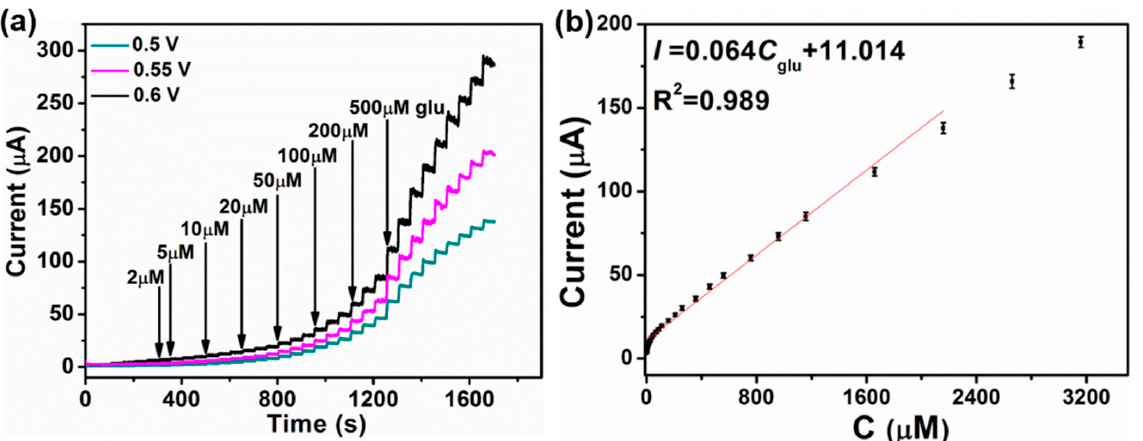
Figure 7. ( a ) Current − time curves of the CuS electrode with the continuous addition of glucose solution at 0.5, 0.55 and 0.6 V (0.1 M NaOH), respectively. ( b ) The calibration curves fitted from the current responses at 0.6 V.